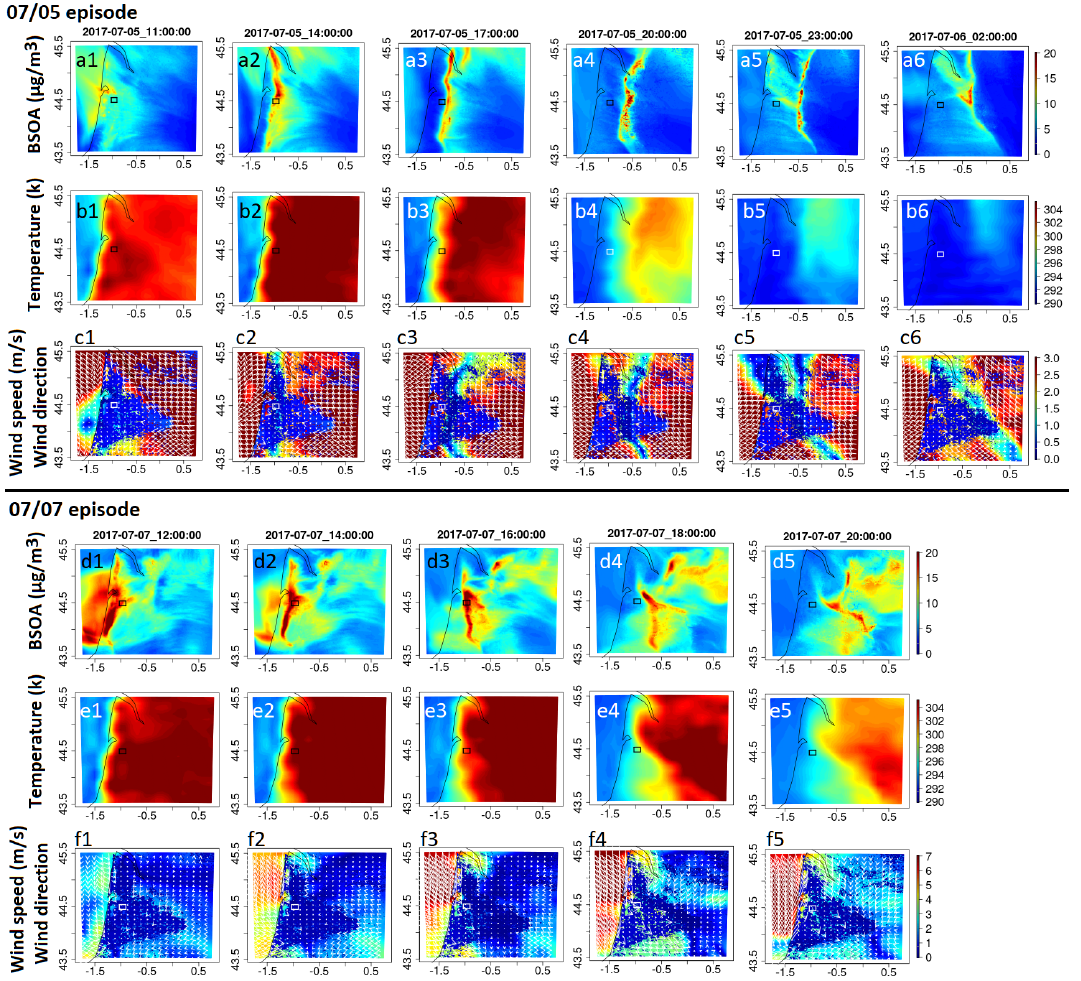
Figure 14. Sea breeze event for 5 and 7 July. The date and time of each panel are shown at the top of each panel, and each row represents one variable or species, with the name and the unity mentioned on the y